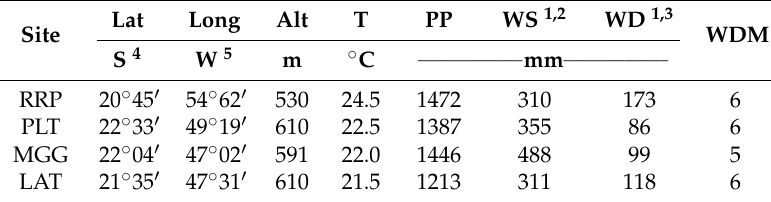
Table 1. Latitude (Lat), longitude (Long), altitude (Alt) and mean annual values for temperature (T), pluviometric precipitation (PP), water surplus (WS), water deficit (WD) and months with WD per year (WDM) in each site. RRP, Ribas do Rio Pardo; PLT, Paulistania; MGG, Mogi Guacu; LAT, Luis